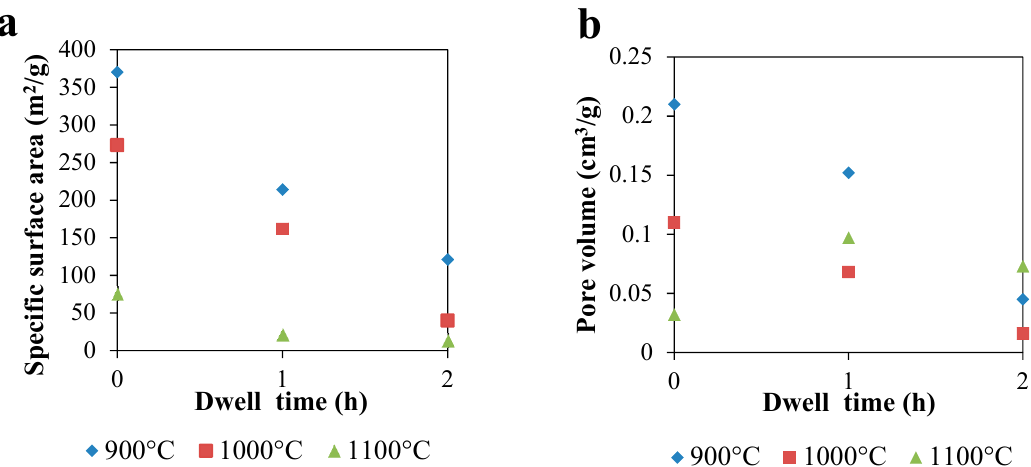
Figure 2. Effect of dwell time and temperature on morphology of carbon aerogels (CAGs). ( a ) Specific surface area, ( b ) pore volume. Heating rate: 10 °C/min. Table 5. Comparison between pre-treated and pure MFC, carbonized at the same conditions.